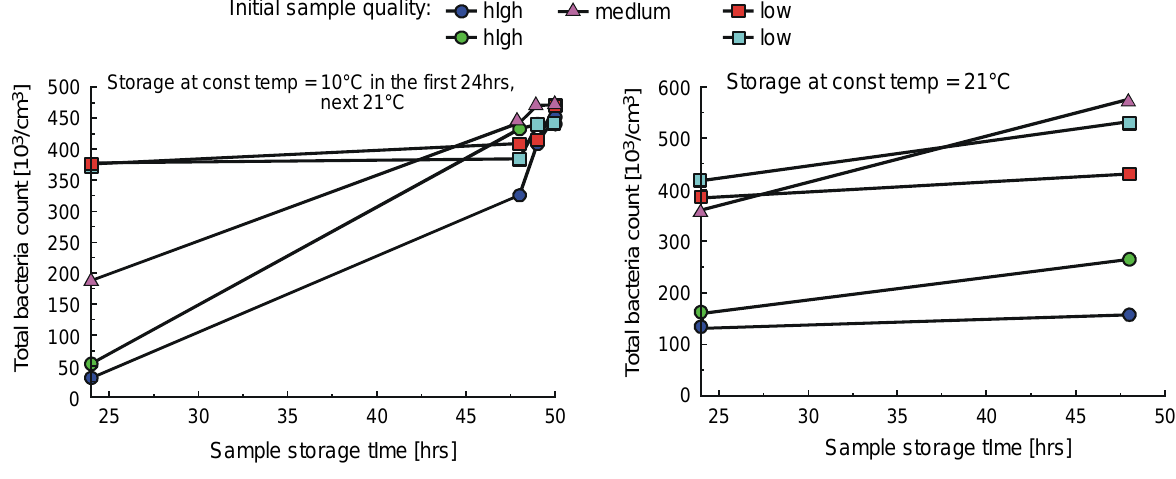
Figure 16. Total bacteria count of raw milk samples stored under different